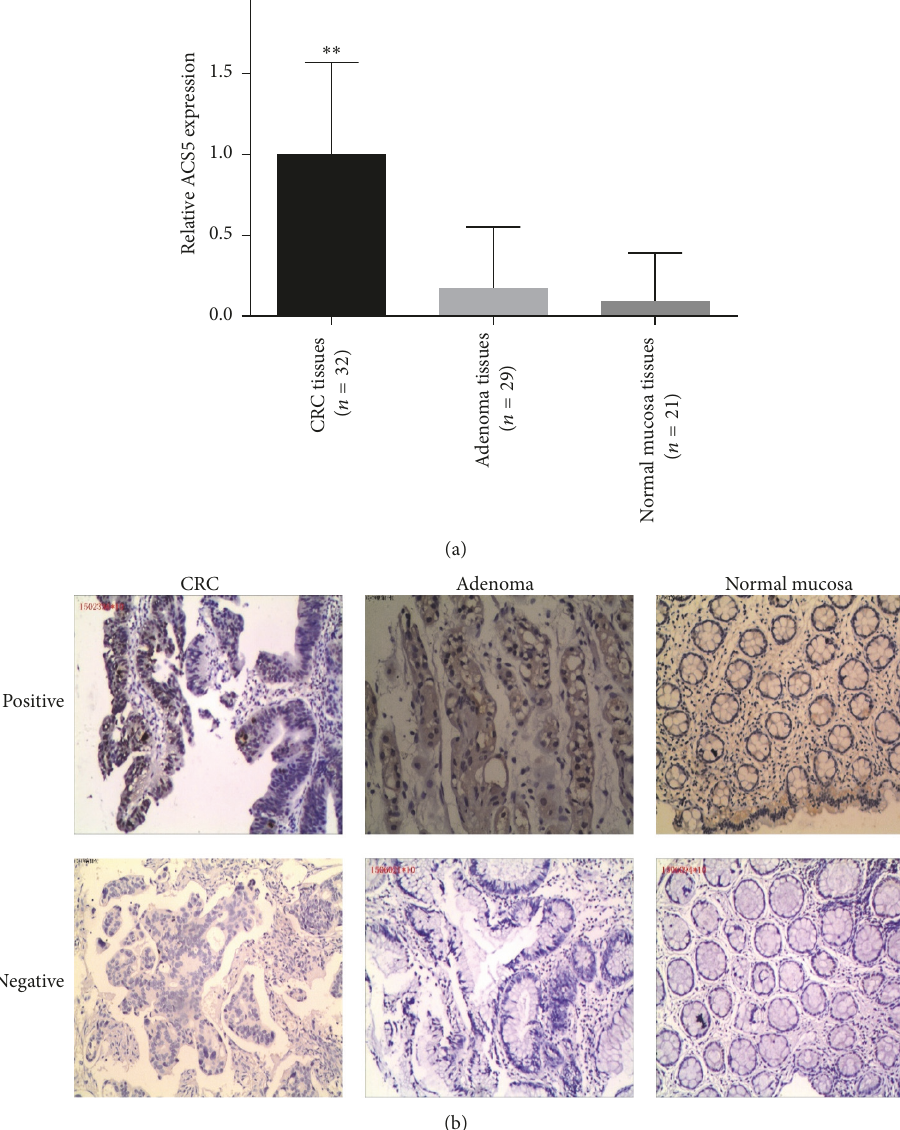
Figure 2: ACS5 overexpression in CRC tissues. (a) The ACS5 protein level was significantly upregulated in CRC tissues compared with adenoma tissues and normal mucosa tissues. (b) Representative photographs of ACS5 staining in CRC, adenoma, and normal mucosa tissues (stain, hematoxylin; magnification, × 100). ∗∗ 𝑃 < 0.01 versus adenoma tissue or normal mucosa